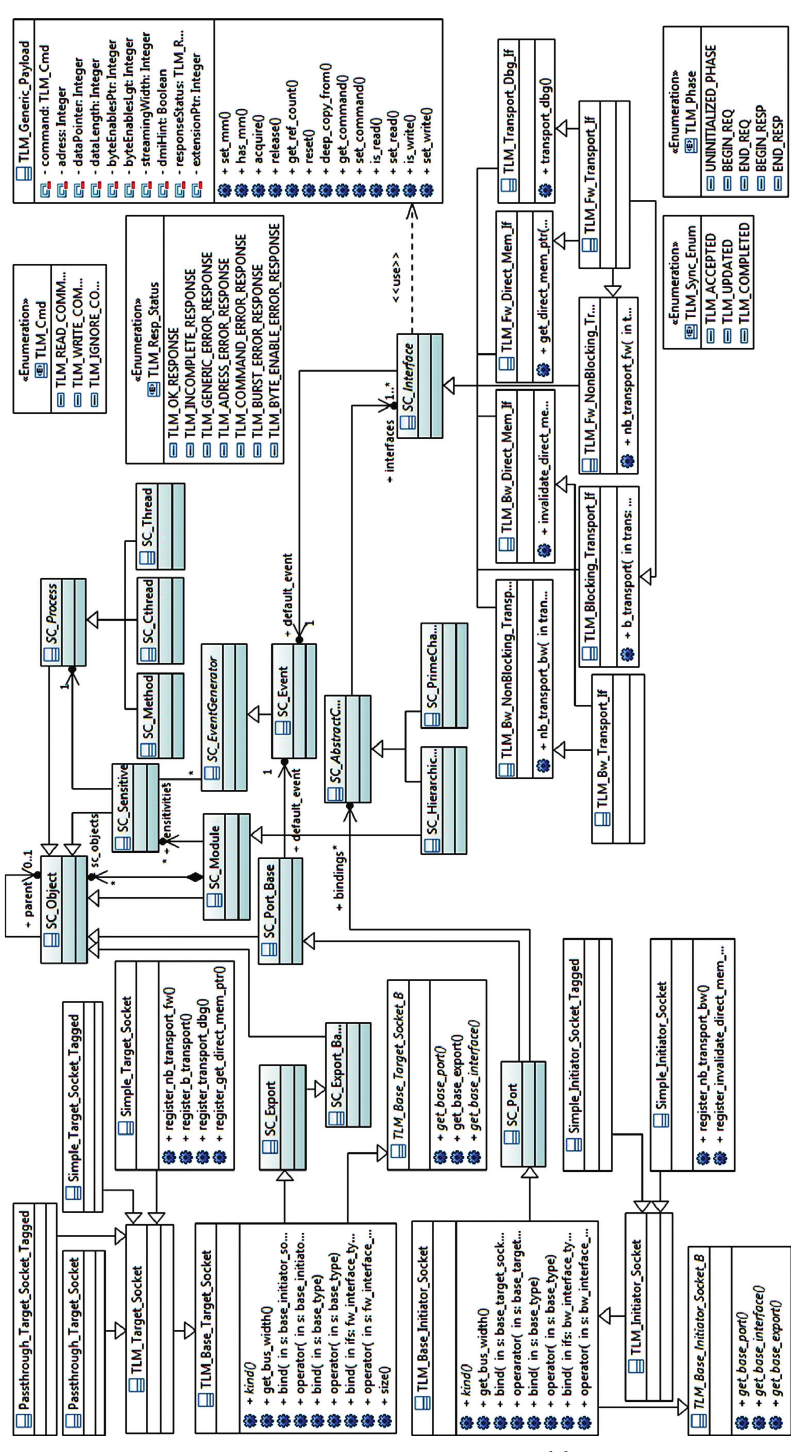
Figure 21: SystemC/TLM